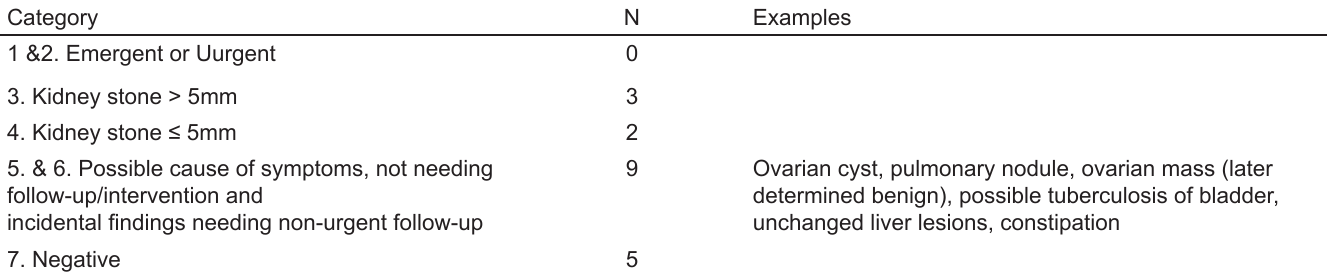
Table 3. Non-renal protocol computed tomography results by category (N = 19).